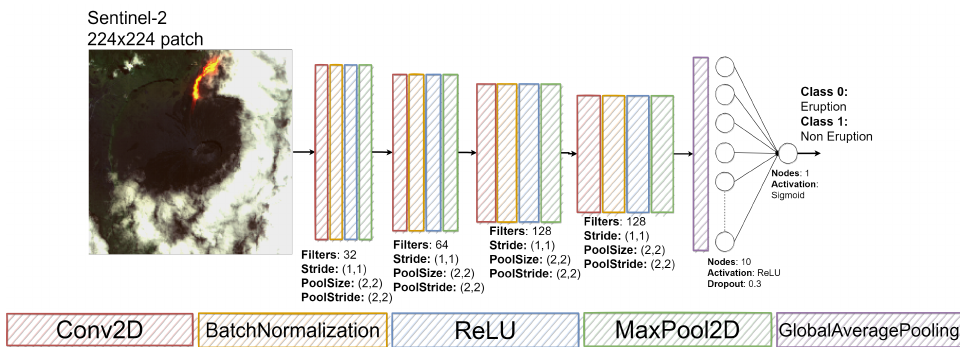
Figure 6. Smaller network